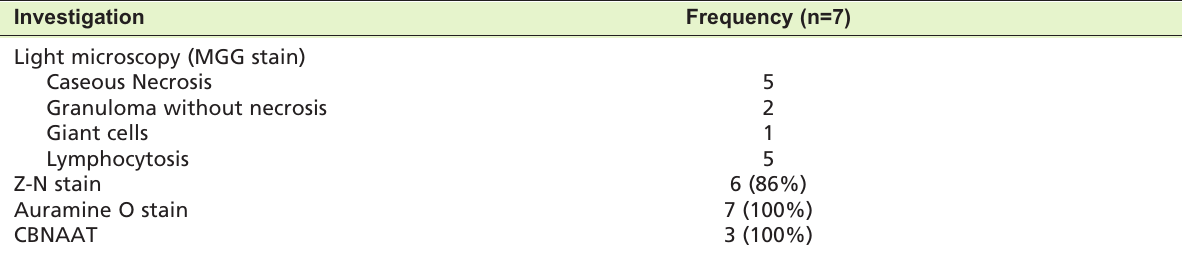
Investigations done on aspirate material Table I: